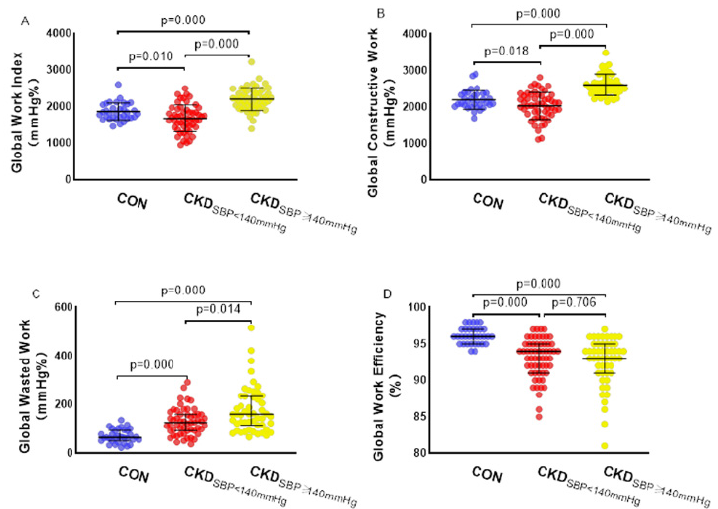
Figure 2. Effect of systolic blood pressure on myocardial work. ( A ) Global work index, ( B ) global constructive work, ( C ) global waste work, ( D ) global work efficiency. CON: control group; CKD SBP<140 mmHg : chronic kidney disease with systolic blood pressure < 140 mmHg group; CKD SBP ≥ 140 mmHg : chronic kidney disease with systolic blood pressure ≥ 140 mmHg group.